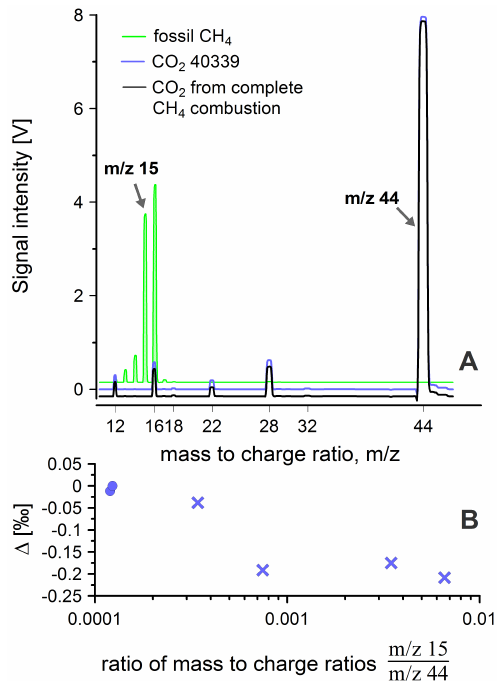
Fig. 4. Assessment of the completeness of the combustion of pure CH 4 gases. A: Shown are three scans of mass abundances, each resulting from the injection of one gas into the ion source of the dual inlet IRMS. The lines result from pure CH 4 (green line), the pure CO 2 -40339 (blue line) and CO 2 derived from a completely combusted CH 4 sample (black line). Because all measurements have the same background signal and would overlap, the green and the black line are artificially offset by 0.15 V and -0.15 V, respectively, to highlight the details. Both CH + 4 and CO + 2 decompose in the source, but a signal on mass to charge ratio m/z 15 can only result from injection of CH 4 , while only injected CO 2 produces a signal on m/z 44. The ratio of m/z 15 over m/z 44 can therefore be used to quantify the remaining fraction of CH 4 within the CO 2 of a combusted sample. A high ratio of m/z 15 over m/z 44 indicates a large fraction of CH 4 in the CO 2 gas, hence an incomplete combustion. B: The difference between measured and expected δ 13 C − CH 4 ( ∆ ) in dependence on the completeness of combustion. CO 2 from completely combusted CH 4 gas shows ratios of m/z 15 over m/z 44 of ≤ 0.0002 (blue circles), indicating absence of CH 4 . Incomplete CH 4 combustion produces offsets in normalized δ 13 C − CH 4 (blue crosses). Complete combustion is reached after 25 cryo-transfers when m/z 15 over m/z 44 in the CH 4 derived CO 2 is ≤ 0.0002 and the δ 13 C − CH 4 offset becomes negligible.